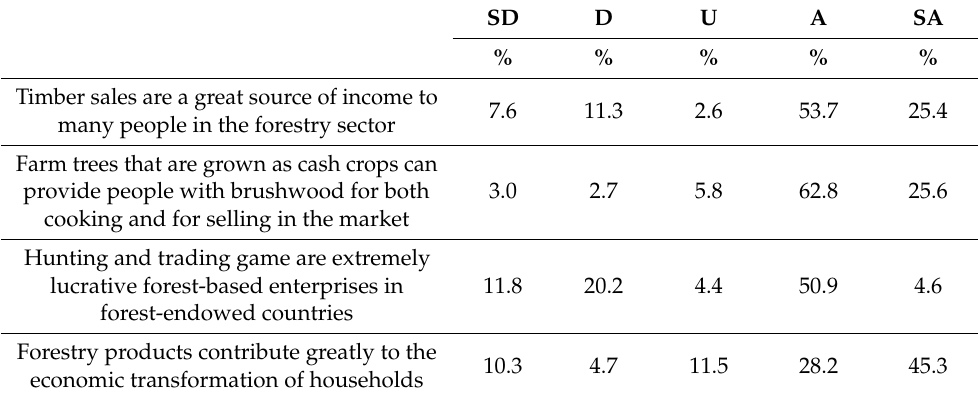
Table 4. Results on direct income from forests.